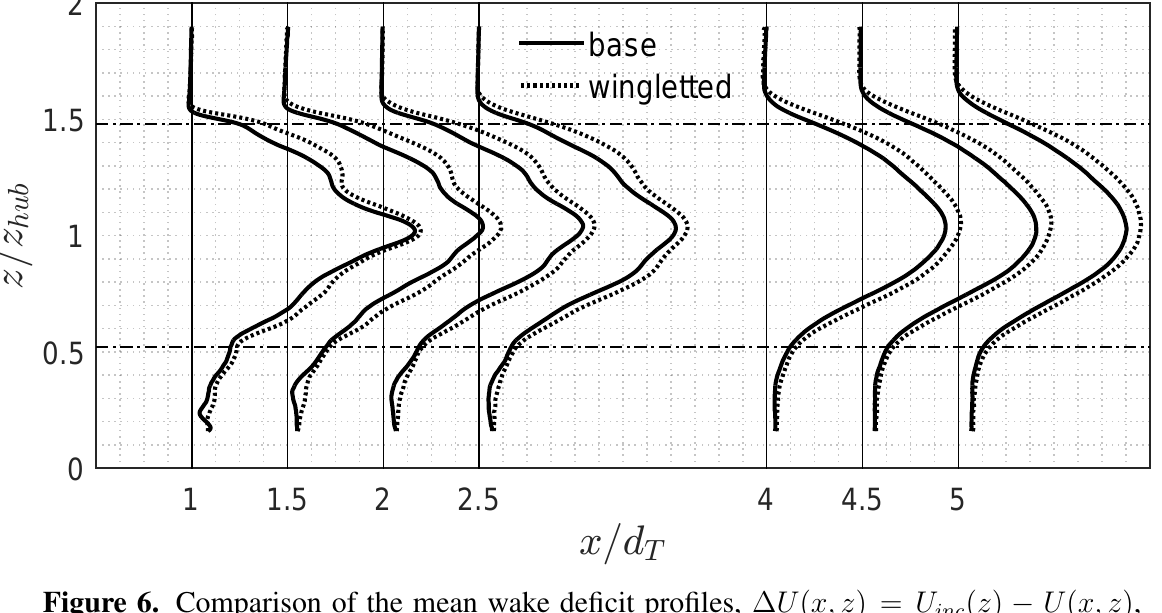
Figure 6. Comparison of the mean wake deficit profiles, ∆ U ( x, z ) = U at the central plane of the standard and wingletted turbine models at several downstream locations. Horizontal dash-dot lines indicate the location of the bottom and top tips of the turbine. Vertical solid lines indicate local zeros, and grid squares have a width of 0.1 × U